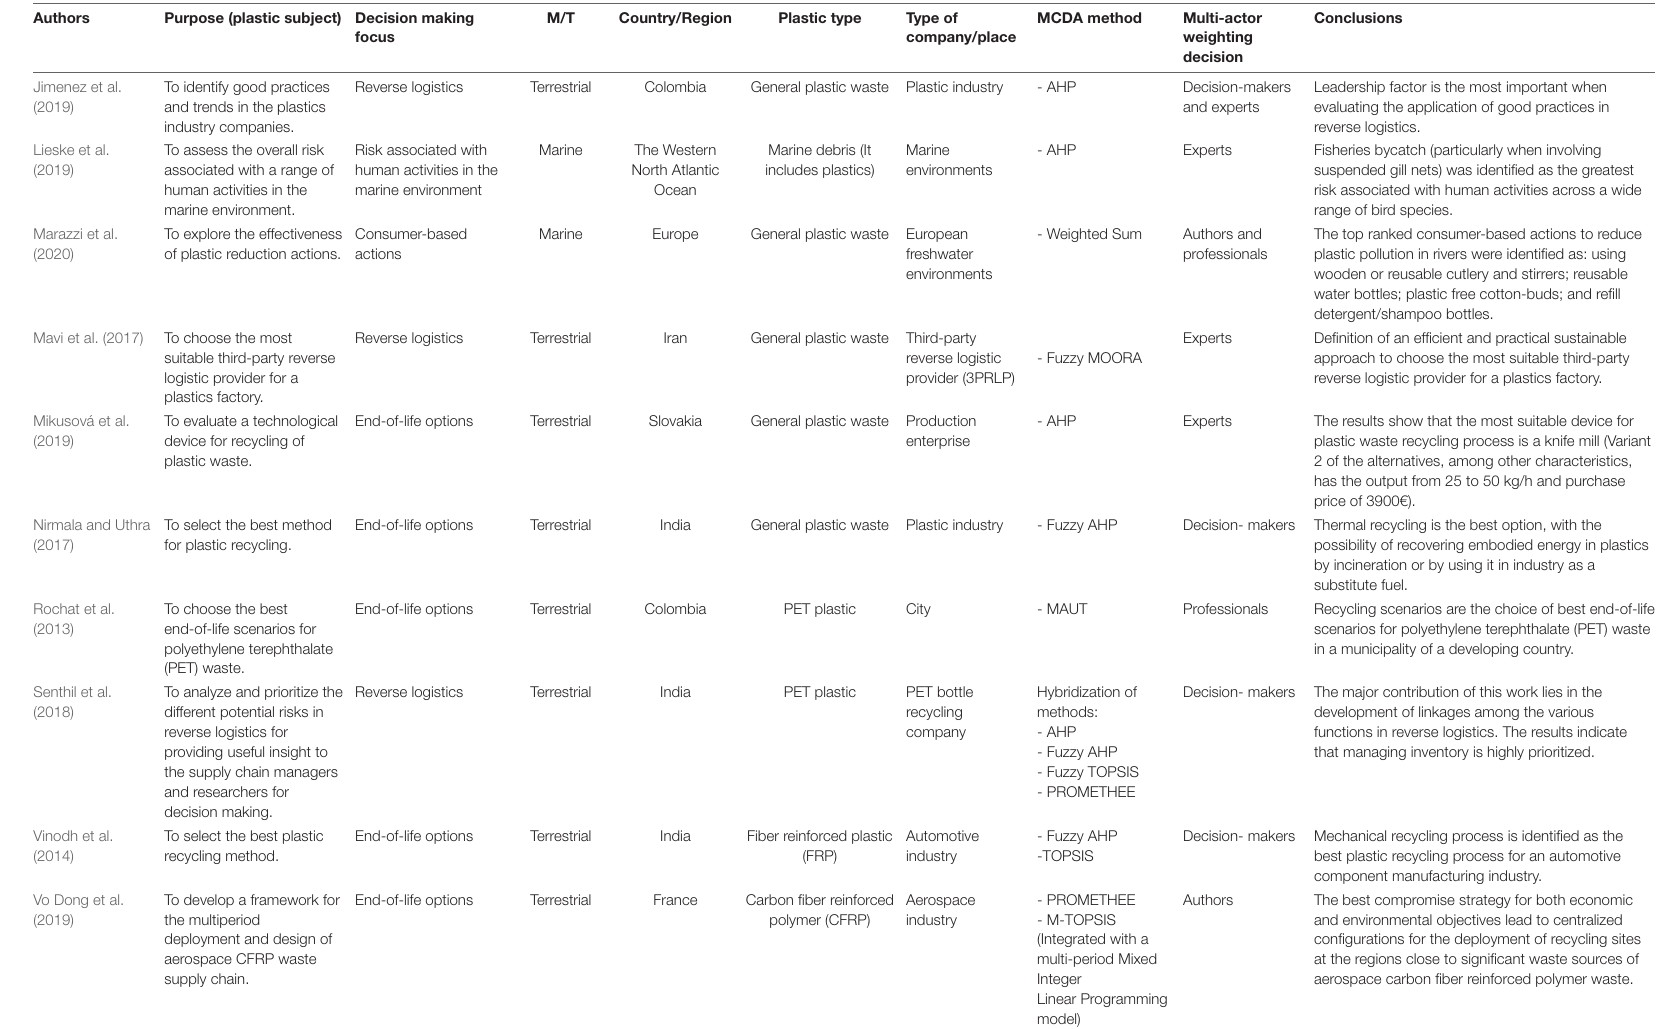
AHP, Analytic Hierarchy Process; ELECTRE, Elimination and Choice Expressing Reality; MAUT, Multi-attribute Utility Theory; MAVT, Multi-Attribute Value Theory; MOORA, Multi-Objective Optimization on the basis of Ratio Analysis; PROMETHEE, Preference Ranking Organization Method for Enrichment Evaluations; THOR, Multicriteria Decision Aiding Hybrid Algorithm; TOPSIS, Technique for Order Preference by Similarity to Ideal Solution; HDPE, High-Density PolyEthylene; LDPE, Low-Density PolyEthylene; PET, PolyEthylene Terephthalates; PP, PolyPropylene; PS, PolyStyrene; PVC, PolyVinyl